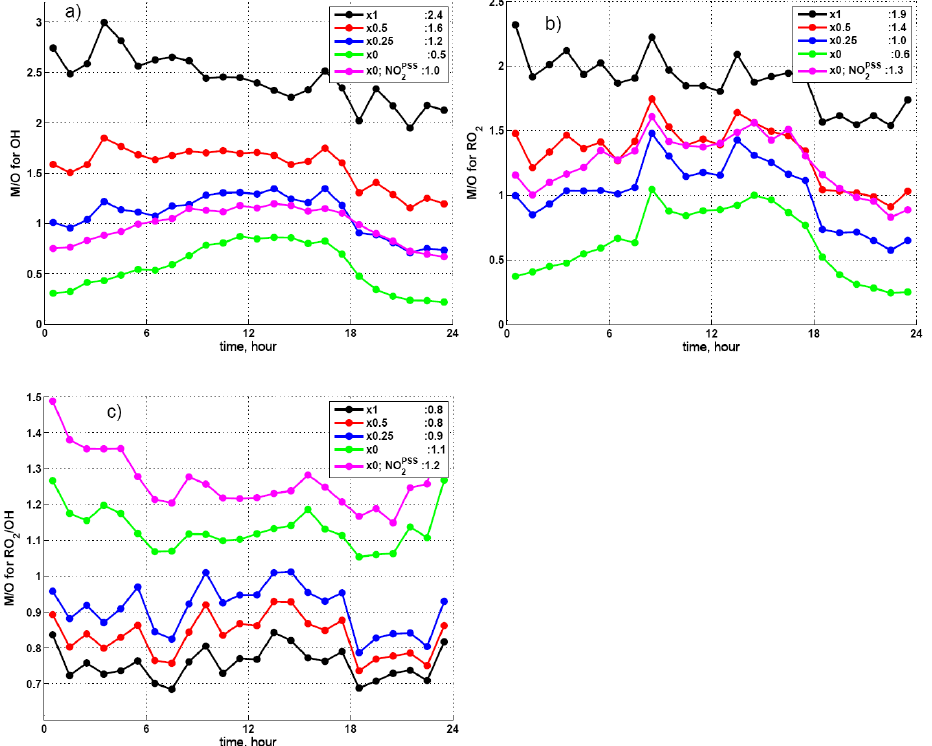
Figure 8. Median diurnal model/observation ratios for [OH] (a) , [RO 2 ] (b) and [RO 2 ] / [OH] (c) at [HONO] = 1, 0.5, 0.25, of measured. The “x0, NO PSS ” curves correspond to the model with [HONO] estimated assuming PSS and [NO 2 ] calculated assuming [NO x ] at PSS. 2 Numbers in legends represent diurnal median M / O